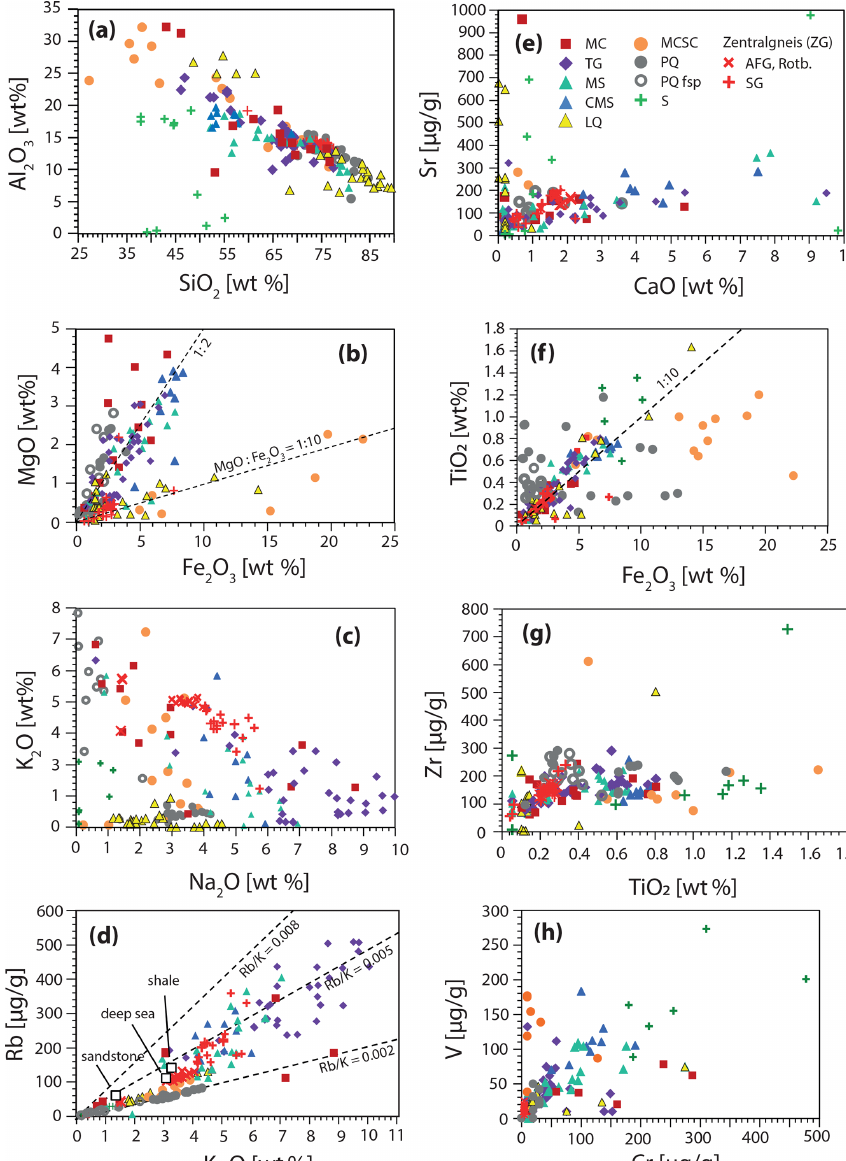
Figure 4. Variation diagrams illustrating the chemical composition of rock units from the Pfitsch area. Data are presented in the data publication (Franz et al., 2021) and include data from the literature and this work. (a) SiO 2 –Al 2 O 3 ; the metasedimentary rock units show a large spread, e.g., tourmaline gneiss ranges from approximately 45wt%SiO 2 to 77wt%SiO 2 and mica schist and carbonate–mica schist from approximately 52wt% to 80wt%SiO 2 . Data points for lazulite quartzite with > 25wt%Al 2 O 3 represent mica-rich selvages around quartz nodules and indicate local transport of SiO 2 (Selverstone and Hyatt, 2003); data points for serpentinite with > 17wt%Al 2 O 3 represent biotite–chlorite-rich blackwall zoning, indicating local metasomatism. The Zentralgneis shows a very restricted composition (one outlier at 60wt%SiO 2 represents a biotite-rich zone). (b) MgO–Fe 2 O 3 ; metasediments follow a broad 1:2 correlation. The MCSC lenses and the lazulite quartzite are significantly enriched in Fe 2 O 3 , the pyrite quartzite and the feldspar-bearing pyrite quartzite are enriched in MgO. (c) Na 2 O–K 2 O; tourmaline gneiss shows high but variable K 2 O contents, and lazulite quartzite is poor in Na 2 O. (d) Rb–K 2 O; trace element Rb is closely coupled to K. The tourmaline gneiss, mica schist and carbonate–mica schist follow a trend of Rb / K = 0.005, close to the trend defined by average composition of shale and sandstone (from Turekian and Wedepohl, 1961), but with a large variation between 0.008 and 0.002. The Zentralgneis variety AFG (Tux branch) and Zillertal branch (Rotbachlspitze) are well correlated, whereas the variety Schrammacher Gneis (SG) shows a large spread. The pyrite quartzite has the lowest Rb / K at below 0.002. (e) Sr–CaO; although Sr is broadly coupled to Ca, there are extreme Sr enrichments in samples of the lazulite quartzite (inset), due to celestite in some samples (Morteani and Ackermand, 1996). (f) TiO 2 and Fe 2 O 3 (total) are positively correlated near to a value of 1:10, although with a large scatter; the paleosol has high Fe 2 O 3 contents. Lazulite quartzite samples with high TiO 2 / Fe 2 O 3 values represent mica-rich selvages around quartz (Selverstone and Hyatt,